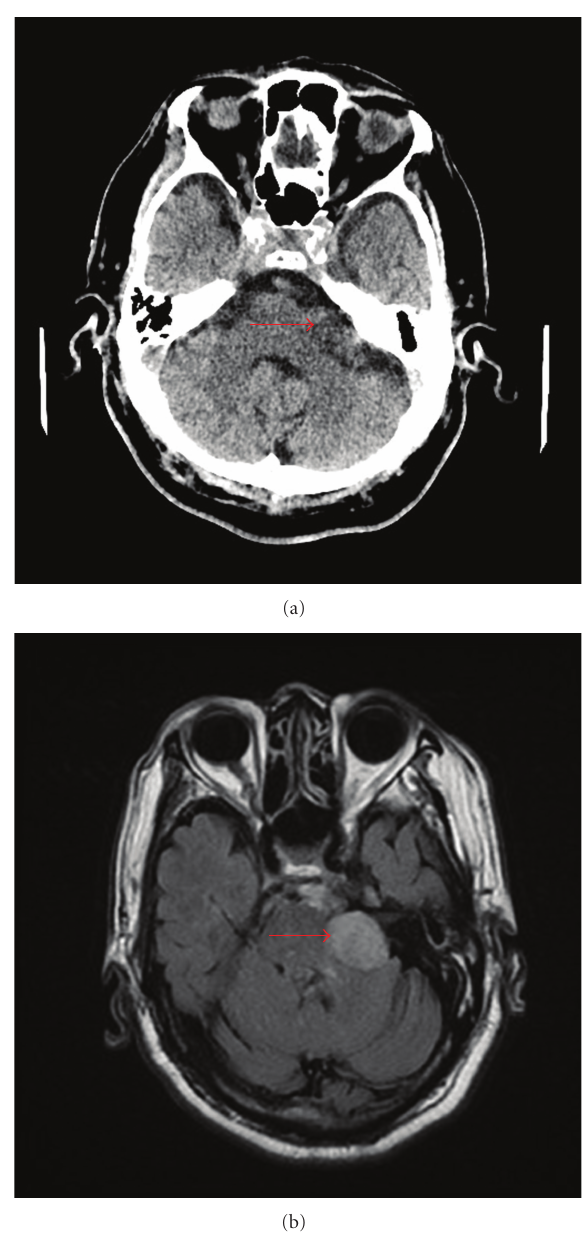
Figure 1: (a) Non-contrast head CT showing a heterogeneous lobulated mass within the left cerebellopontine angle (arrow). (b) Followup brain MRI in same patient 3 days